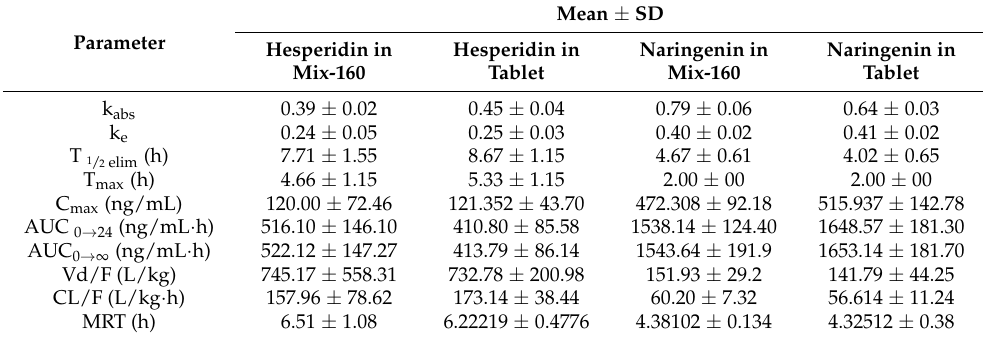
Table 1. Pharmacokinetic parameter results of hesperidin and naringenin in Mix-160 and tablet.